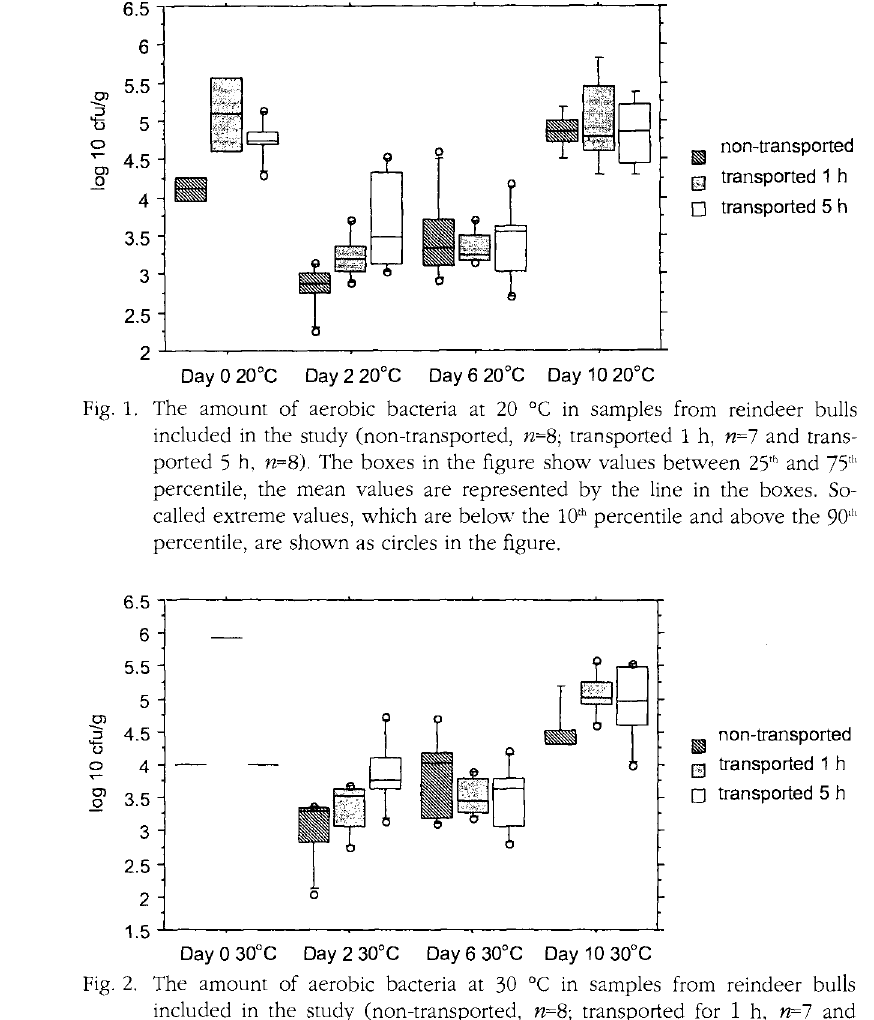
Fig. 2. The amount of aerobic bacteria at 30 °C in samples from reindeer bulls included in the study (non-transported, n=8; transported for 1 h, w=7 and transported for 5 h, n=8). The boxes in the figure show values between 25 lh and 75 th percentile, the mean values are represented by the line in the boxes. So-called extreme values, which are below the 10 th percentile and above the 90"' percentile, are shown as circles in the figure. There are no boxes at day 0 because most of the values were below 4.0 cfu/g, which were the lowest dilution for the serial at day